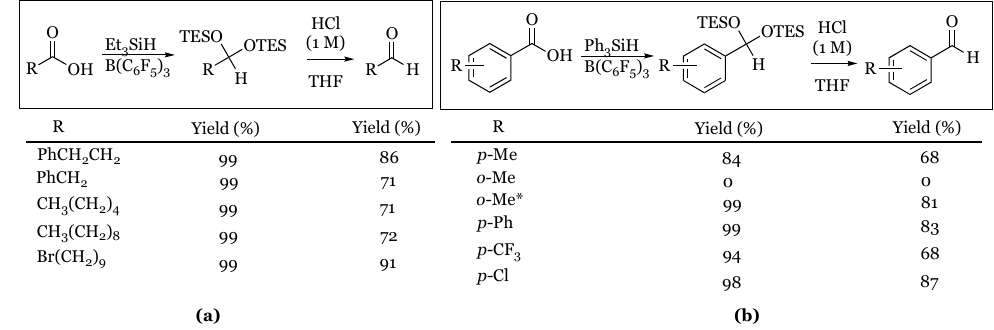
Figure 5. Hydrosilylation of olefins: ( a ) styrene derivatives with Et 3 SiH; ( b ) aliphatic systems with PhMe 2 SiH. c Product ratio cis: trans = 96:4.